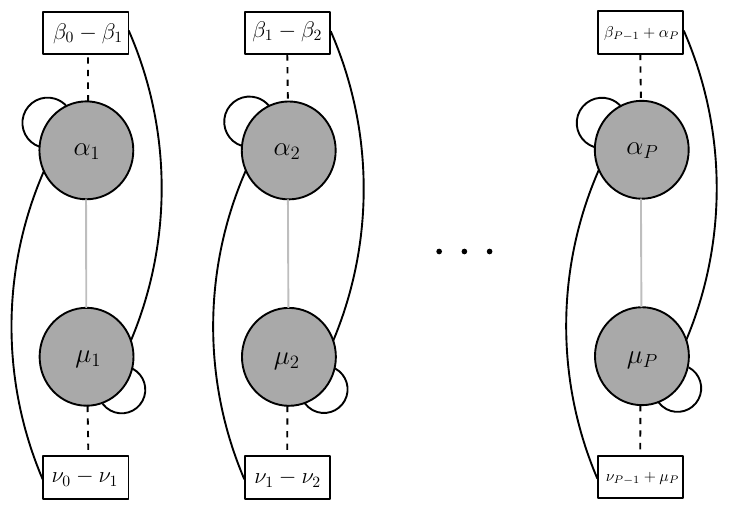
Figure 2 . Disconnected quivers describing the SCQMs dual to our